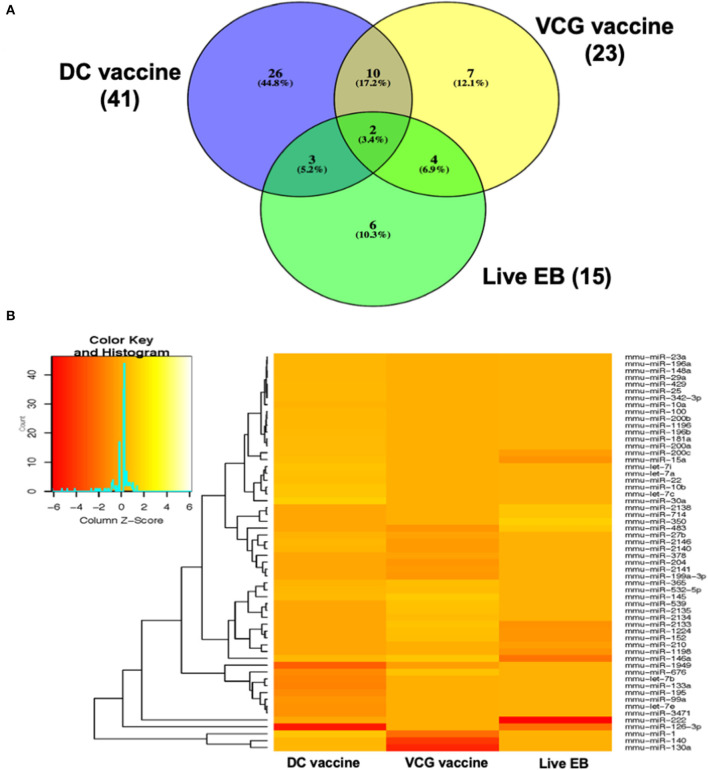
Cluster and Heat map analysis of miRNAs significantly differentially expressed in UGT of mice after vaccine immunization and live Chlamydia infection. (A) Venn diagram of the top 58 upregulated and downregulated differentially expressed miRNAs after DC vaccine (41) or VCG vaccine (23) immunization and live Chlamydia infection (15). The numbers indicate the unique and common miRNAs in the immunization and infection groups. (B) Hierarchical cluster analysis of the top 58 upregulated and downregulated differentially expressed miRNAs after vaccine immunization and live Chlamydia infection. Each row represents a miRNA and each column, an immunization or infection group. On the scale of fold regulation, yellow corresponds to upregulated miRNAs, red corresponds to downregulated miRNAs, and brown indicates no expression difference.